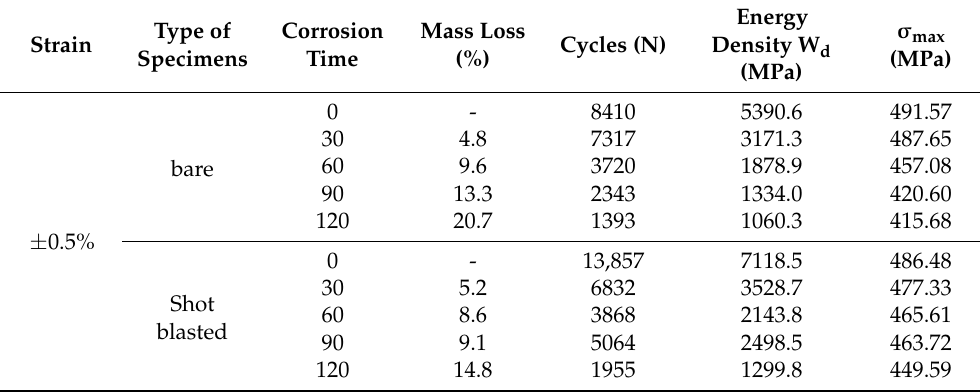
Table 7. Results of LCF tests with free length 6Ø conducted on bare and shot blasted specimens (in non-corroded and corroded conditions) for imposed deformation ± 0.5%. Type of Strain